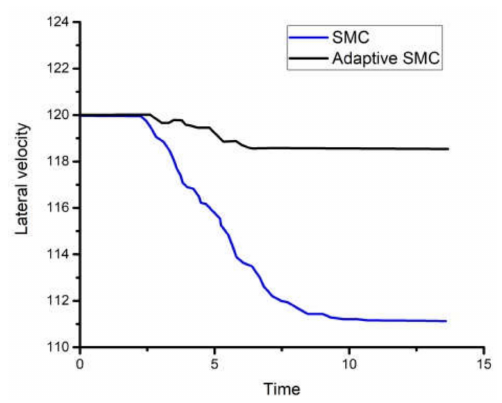
Figure 10. Lateral velocity.